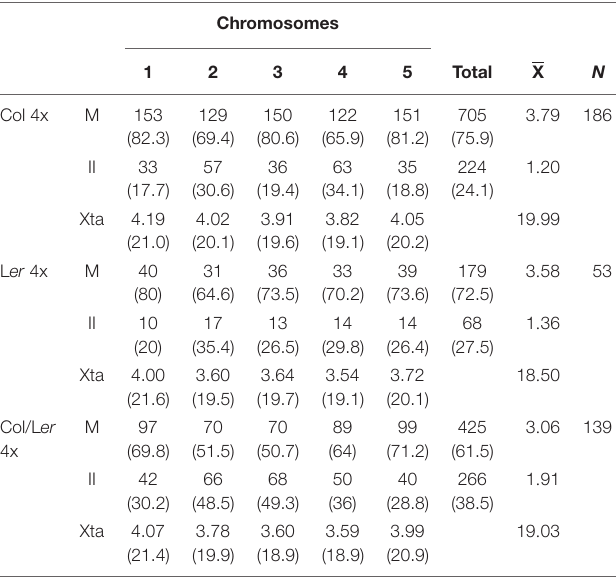
TABLE 1 | Chiasma frequencies observed for the different chromosomes (1–5) in PMCs from Col, L er, and Col/L er diploid plants. Chromosomes